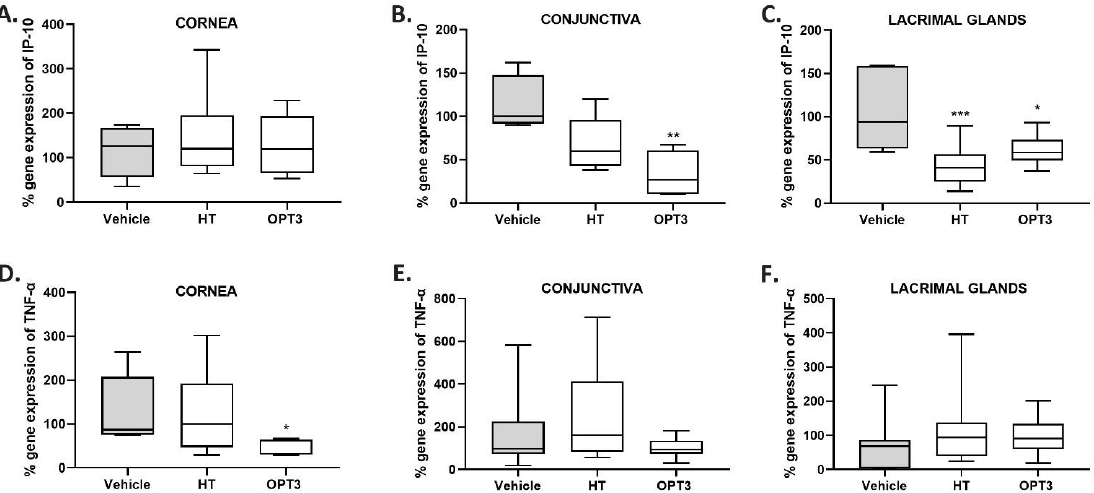
Figure 5. Effect of a selected crude OP extract (OPT3) (0.20 mg/mL) and HT (100 μM/0.015 mg/mL), on IP-10 ( A – C ) and TNF-α ( D – F ) gene expression in the cornea ( A , D ), conjunctiva ( B , E ), and lacri- glands ( C , F ) of 14-days-DS-exposed mice after topical application. IP-10 gene expression was reduced in conjunctiva by OPT3 ( B ) and in lacrimal glands by both treatments ( C ). TNF- α gene expression was decreased only in the cornea by OPT3 ( D ). *** p -value < 0.001, ** p -value < 0.01, * p -value < 0.05, compared with vehicle-treated mice (borate